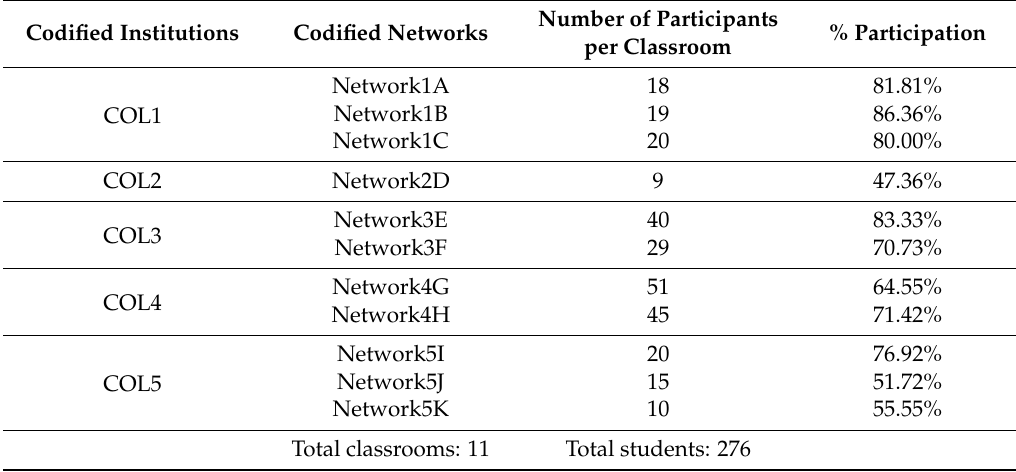
Table 1. Composition scheme for the contact networks from the teaching classroom in each educational institution, and the corresponding participation rates.